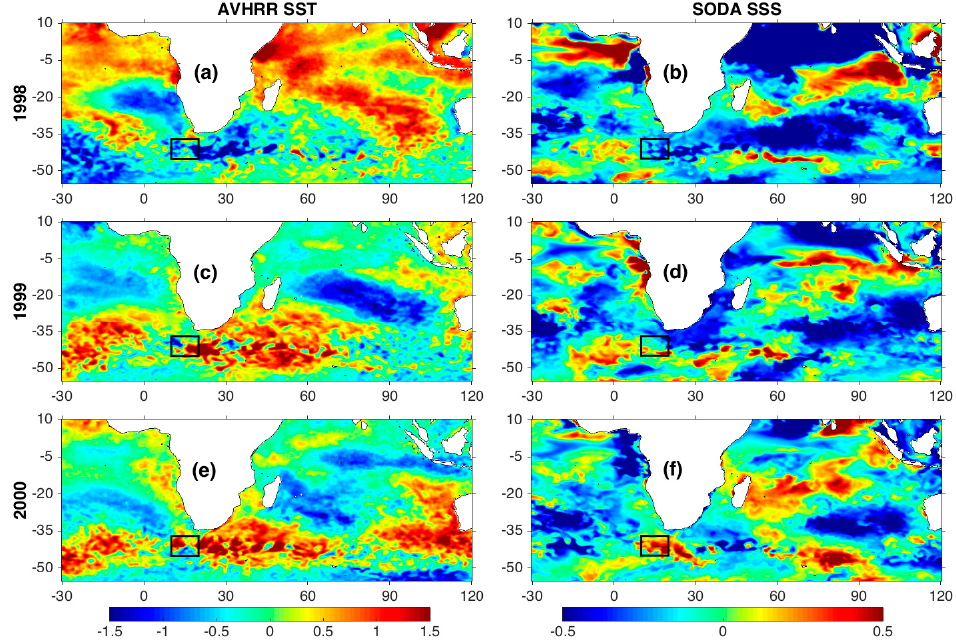
Figure 5. Same as Figure 4 except in reference to the strong 1997–1998 El Niño event during the peak ( a , b ), the following year ( c , d ), and two years after ( e , f ).